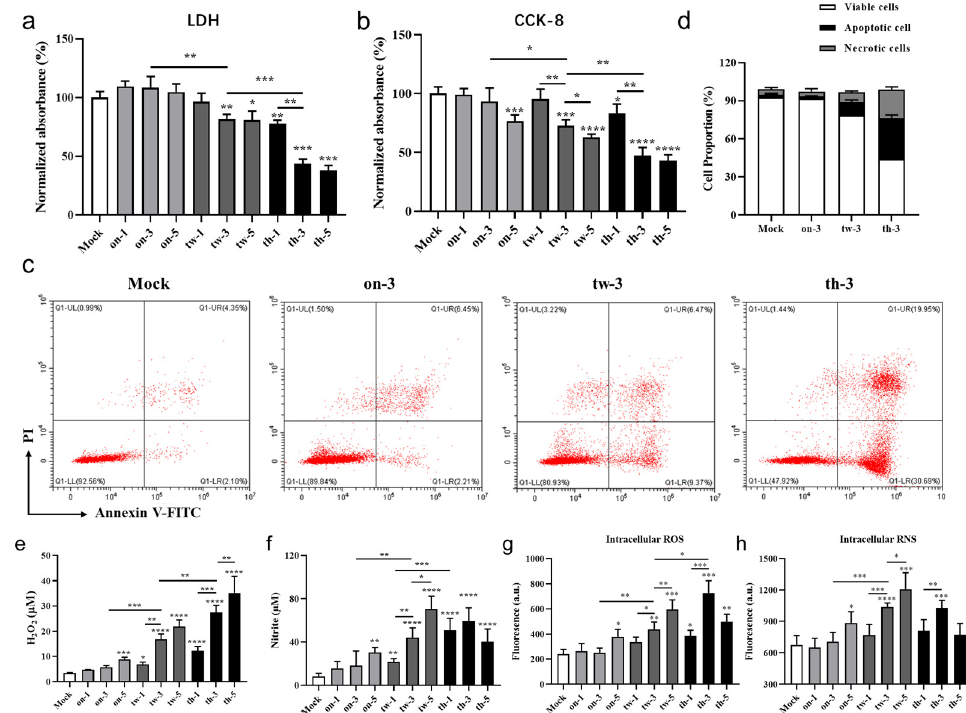
Figure 2. CAP treatment-induced cytotoxicity, apoptosis, and necrosis in MC38 cells in vitro via ROS/RNS generation. The MC38 cells are cultured for three days. Nine different exposure times and frequencies of CAP treatment are generated based on the different combinations of treatment frequencies and durations per treatment. ( a , b ) The normalized absorbance values of LDH (OD490) and CCK-8 (OD450) assays conducted with MC38 cells in both the control (mock) and PT groups, n = 4. ( c , d ) Flow cytometry analyses based on Annexin-V/PI staining to determine apoptotic and necrotic MC38 cells in the mock and PT groups (on-3, tw-3, and th-3), with logarithmic plots ( c ) and percentages of apoptotic cells ( d ), n = 3. ( e , f ) H 2 O 2 and Nitrite concentrations in the MC38 cell culture supernatants in the mock and PT groups, n = 5. ( g , h ) Normalized fluorescence results for the levels of ( g ) intracellular ROS and ( h ) RNS in the MC38 cells treated with different CAP doses, n = 5. The data represent a minimum of three independent experiments (means ± SD). Statistical analysis is performed for all the PT groups using two-sided unpaired t -tests relative to the mock group (* p < 0.05, ** p < 0.01, *** p < 0.001, and **** p < 0.0001).